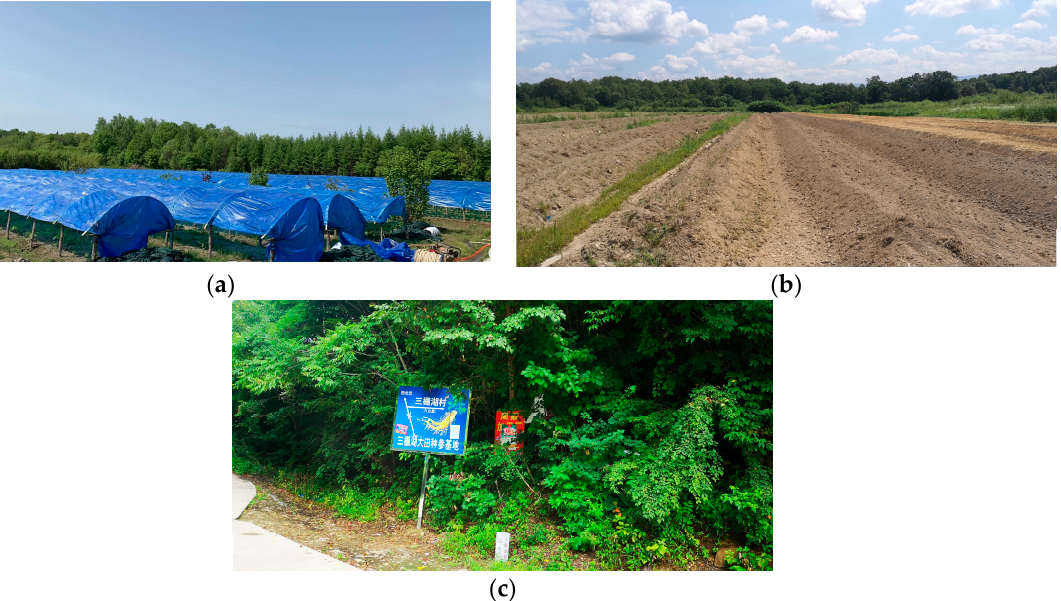
Figure 1. Pictures of the native and vegetated plant communities of soil samples. ( a ) Picture of the CH and CD collection place. ( b ) Picture of the CK collection place. ( c ) Picture of native and vegetated plant communities. CH—biennial ginseng seedlings that were transplanted and then continuously